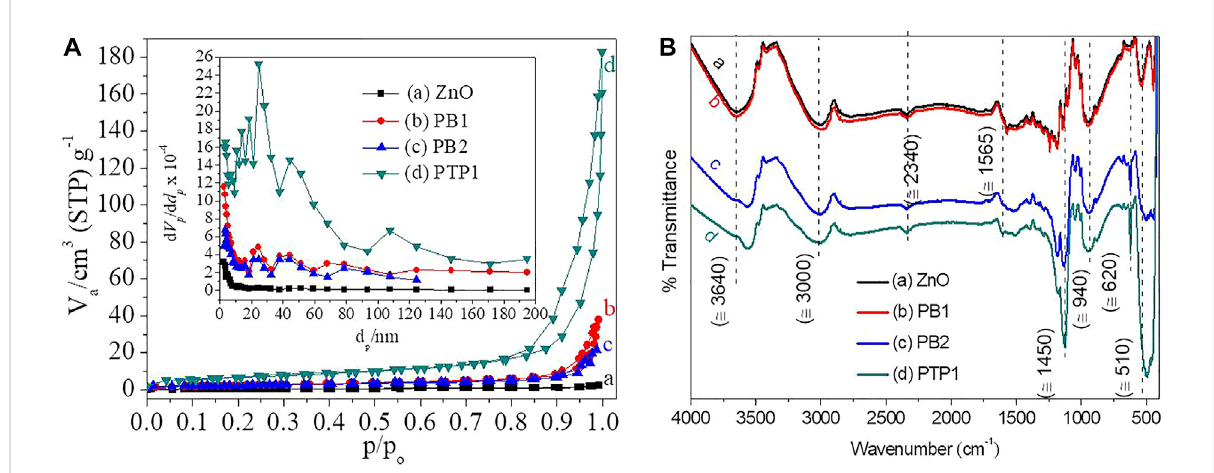
FIGURE 3 (A) Textural properties analysis: theBET plots of ZnO NPs and PB1, PB2, and PTP1 NCs (Inset: therespective Barrett – Joyner – Halendaporesize distribution plots). (B) Chemical bonding analysis: FT-IR spectra of ZnO NPs, PB1, PB2, and PTP1 NCs calcined at 500 °